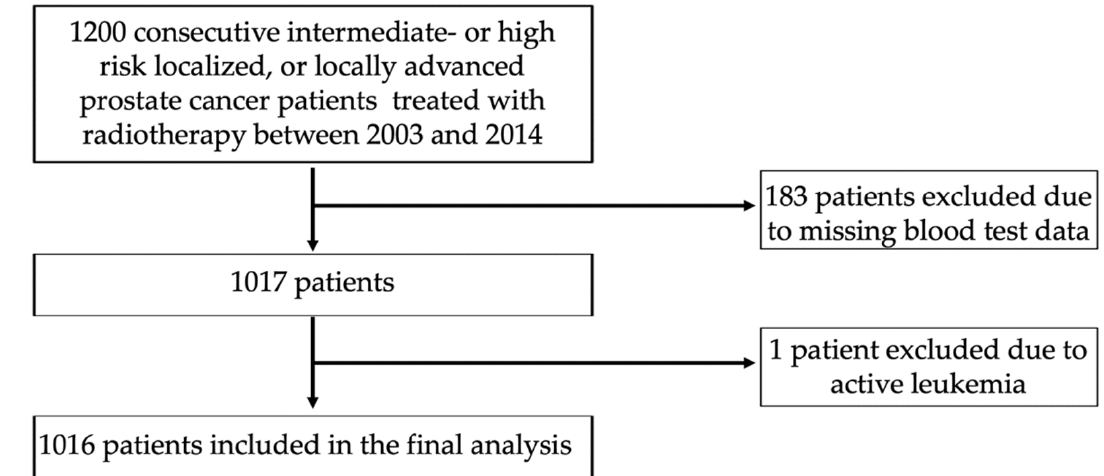
Figure 1. Flow chart of the study population.